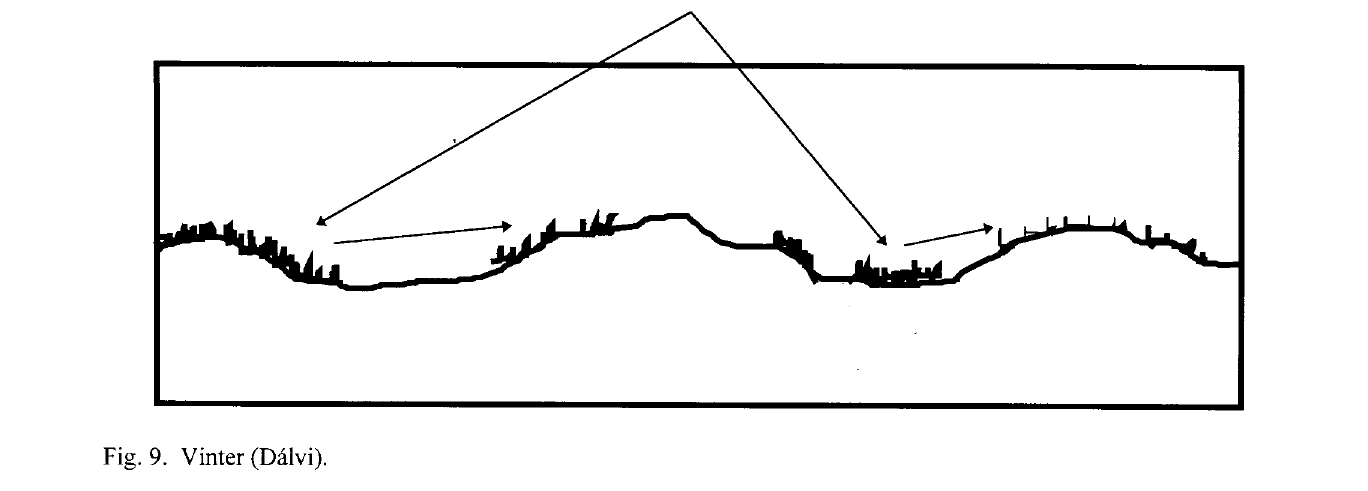
Fig. 9. Vinter (Dålvi).